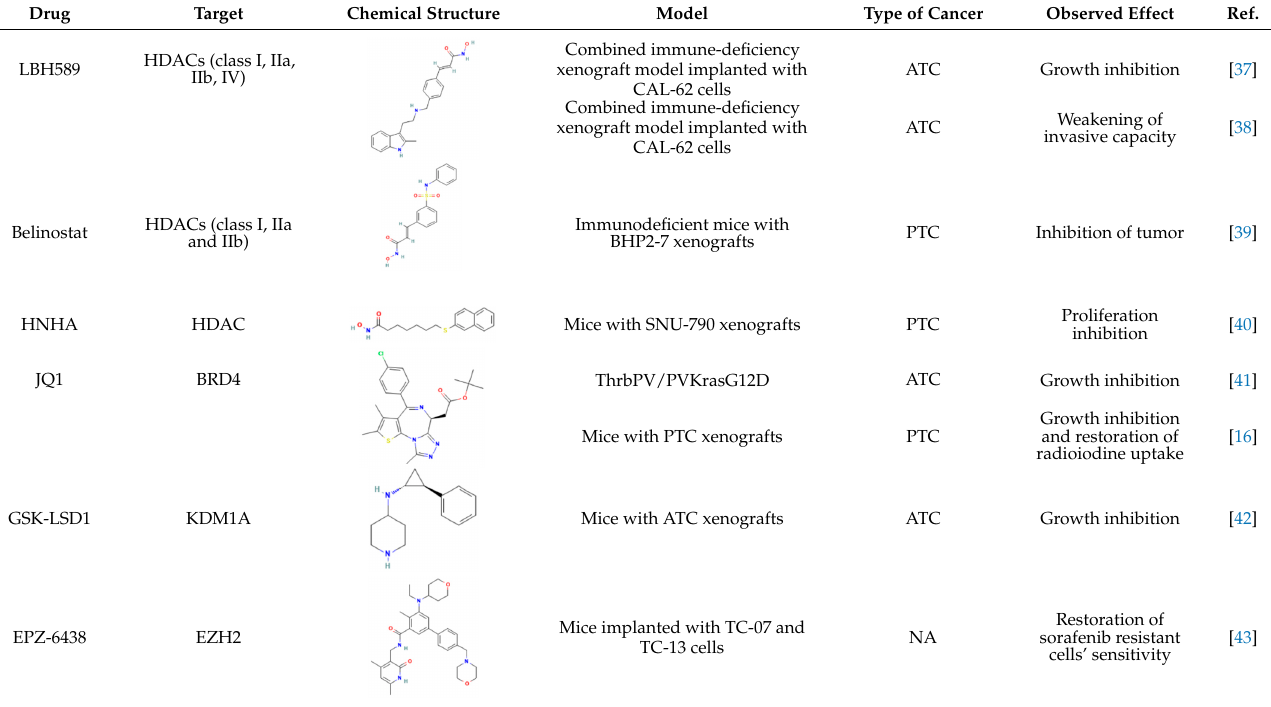
Table 1. In vivo studies on epigenetic agents in thyroid carcinoma models.